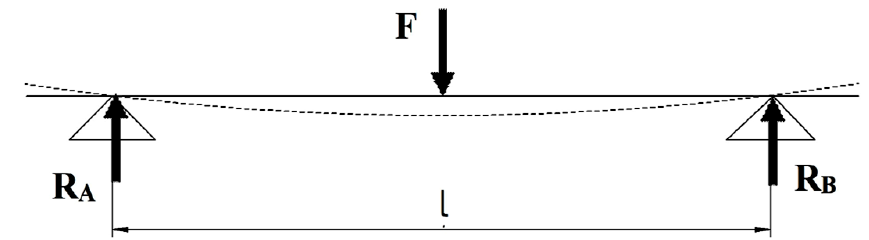
Figure 1. Simple modelling (SM) of bending stress.